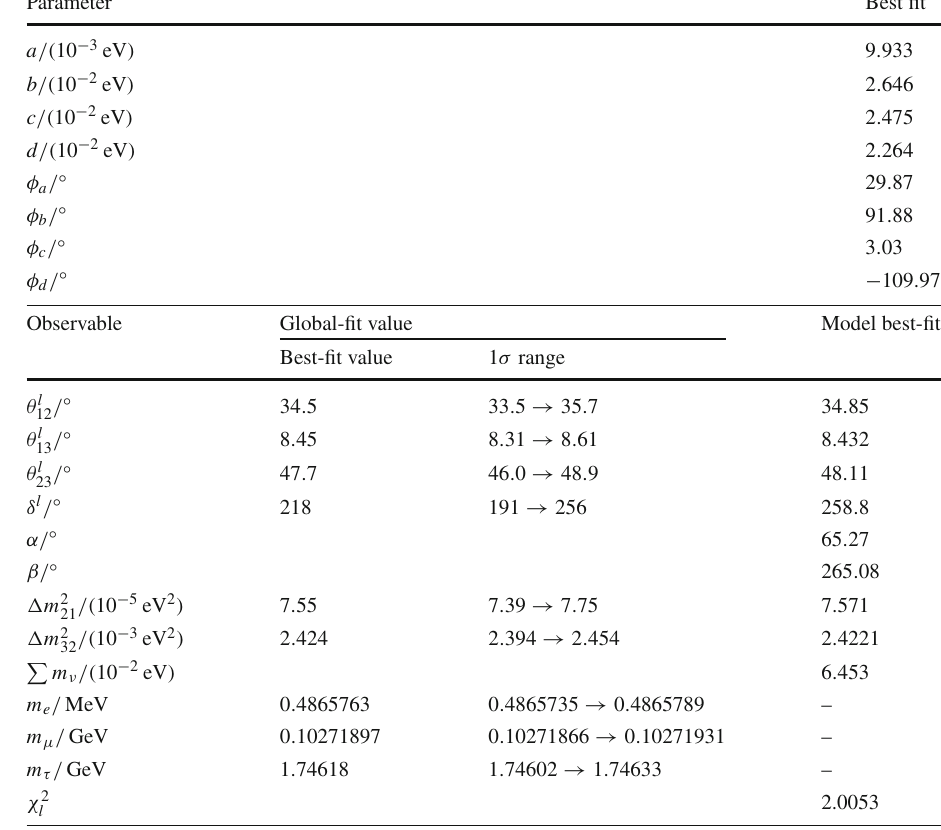
Table 5 Best-fit values of the model parameters in the lepton sector are shown in the upper table. The global best-fit as well as their 1 σ error [5,52] for the various observables are given in the second and third columns of the lower table. Also, the best-fit values of the various observables are listed in the last column of the lower table